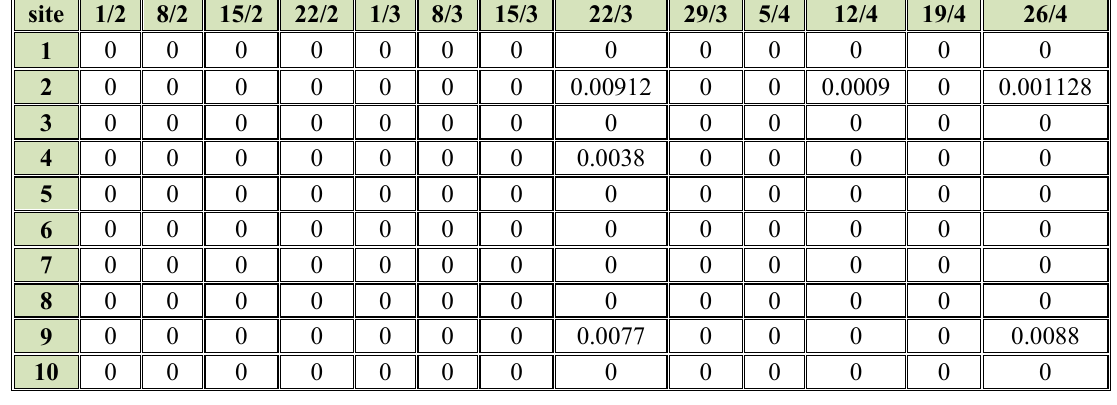
Table 9: Cd values (ppm).